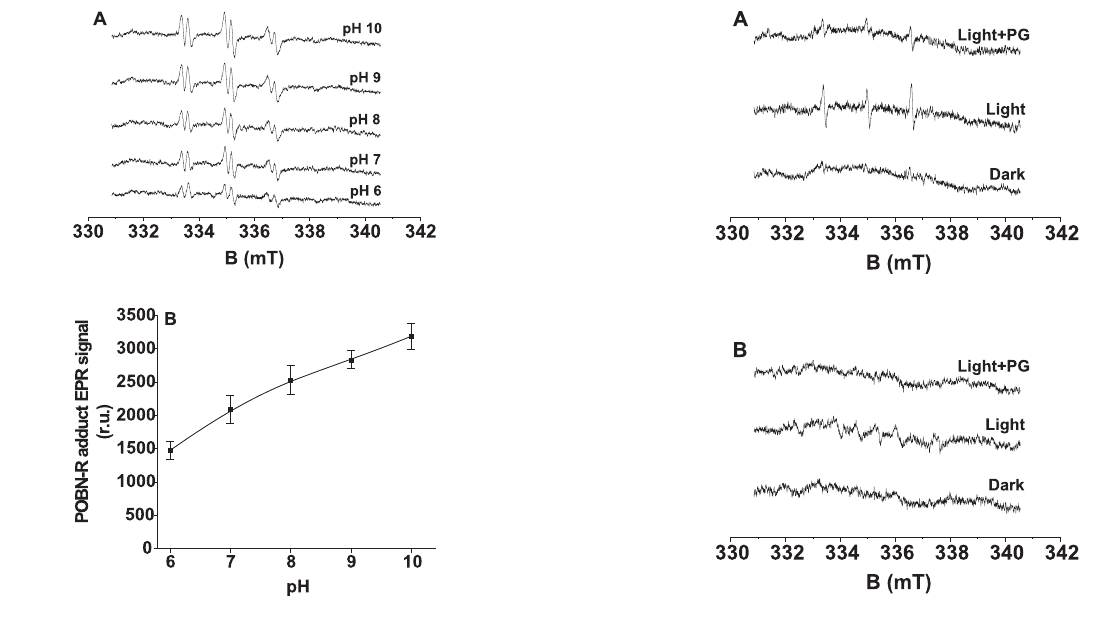
Figure 4. Effect of pH on POBN-R adduct EPR spectra measured in Tris-treated PSII membranes. [A] Tris-treated PSII membranes (200 m g Chl ml 2 1 ) were illuminated with white light (1000 m mol m 2 2 s 2 1 ) for 30 min at different pH as indicated in figure. The measurements were performed in 40 mM MES buffer (pH 6) or 40 mM HEPES buffer (pH 7) or 40 mM TRIS buffer (pH 8) or 40 mM CAPSO buffer (pH 9) or 40 mM CASP buffer (pH 10). [B] pH profile of POBN-R adduct EPR signal measured in Tris-treated PSII membranes under light illumination for 30 min. The intensity of EPR signal was evaluated as the relative height of central peak of the first derivative of the EPR absorption spectrum. The data represent the mean value ( 6 SD) of at least three experiments.